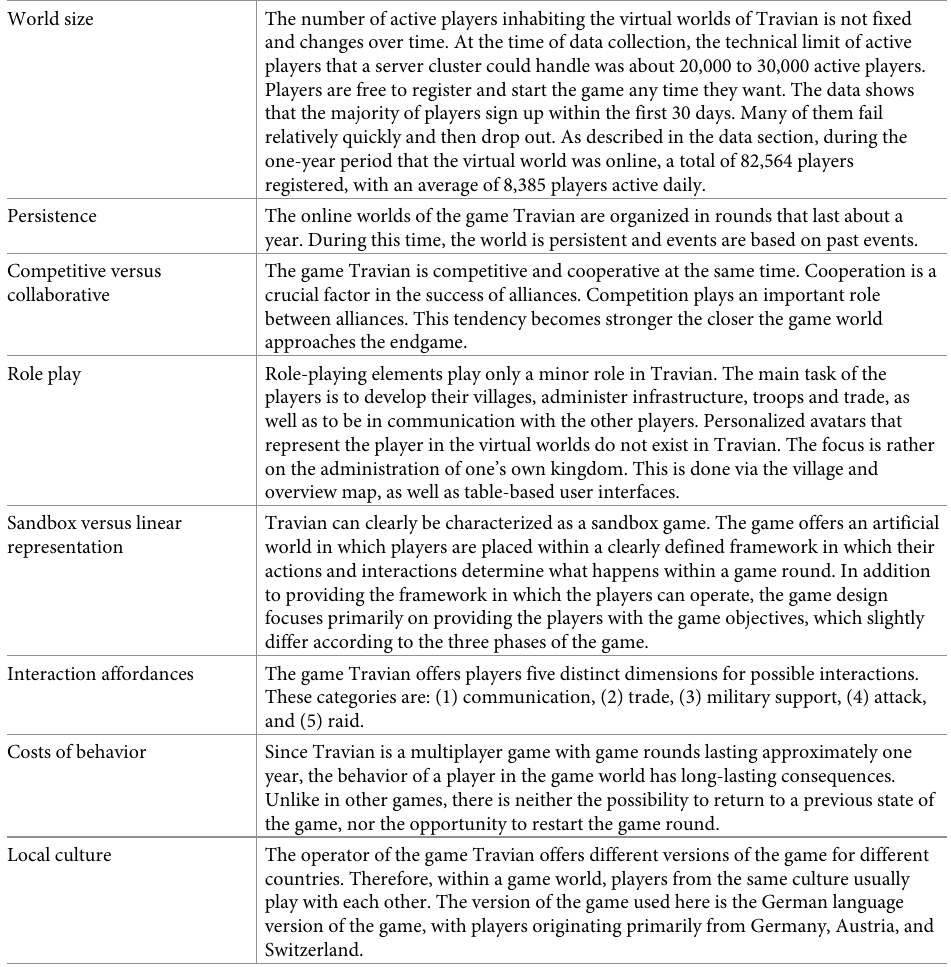
Table 2. The world of Travian—Contextual and social architectural factors based on Williams’ research agenda for virtual mapping and other tests. World